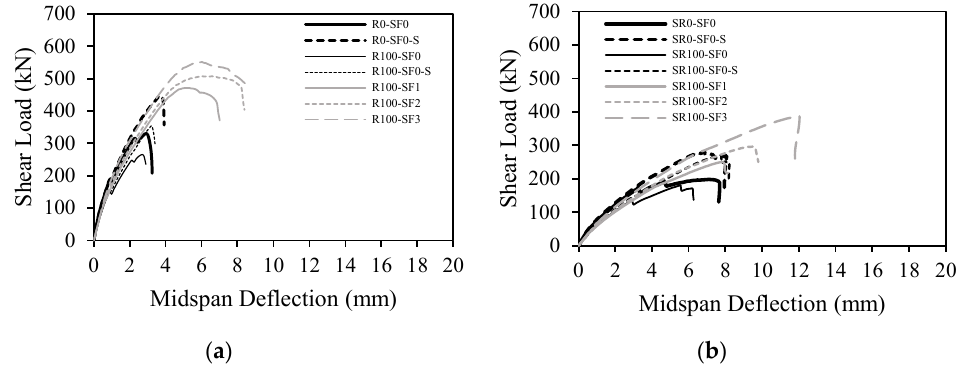
Figure 18. Shear load–deflection responses of solid deep beam models: ( a ) a/h = 0.8; ( b ) a/h = 1.6.